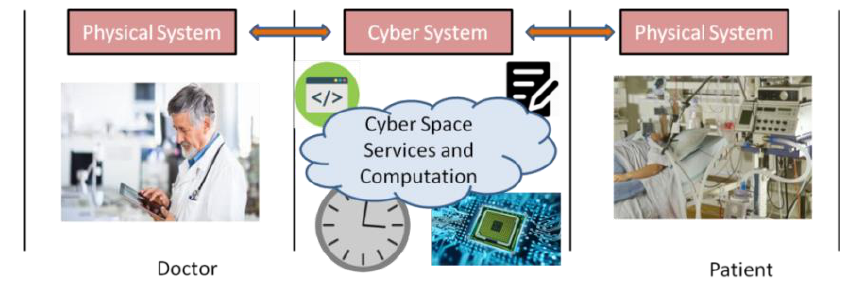
Figure 1. Cyber physical system (CPS) for E-healthcare systems.